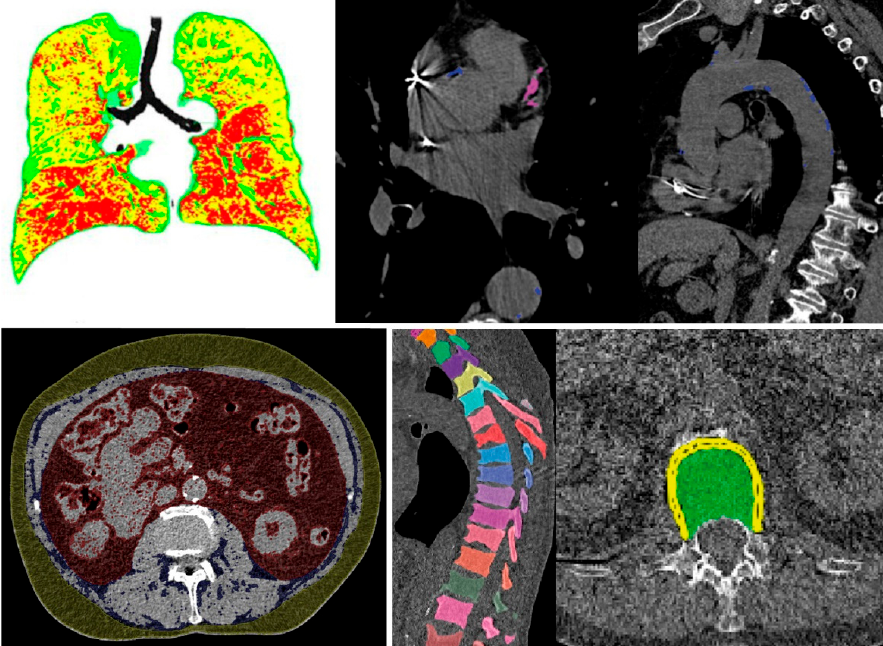
Figure 3. Example no. 2 ‘COPD patient’—Summary of organ segmentations and pathological findings from left to right and top to bottom: COPD, coronary and aortic calcifications, visceral, subcutaneous and intramuscular adipose tissue, and vertebral segmentations for assessment of BMD.